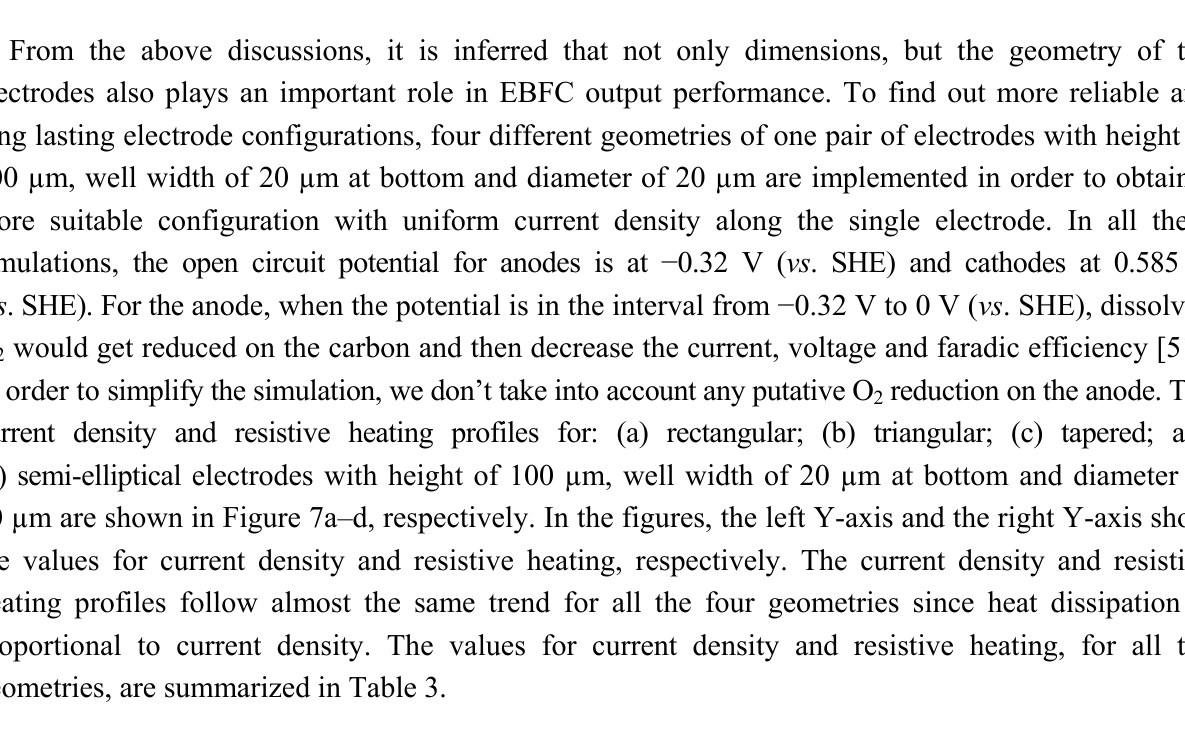
Table 3. Statistical analysis of current density (CD) and resistive heating (RH) for rectangular, triangular, tapered and semi-elliptical geometry of